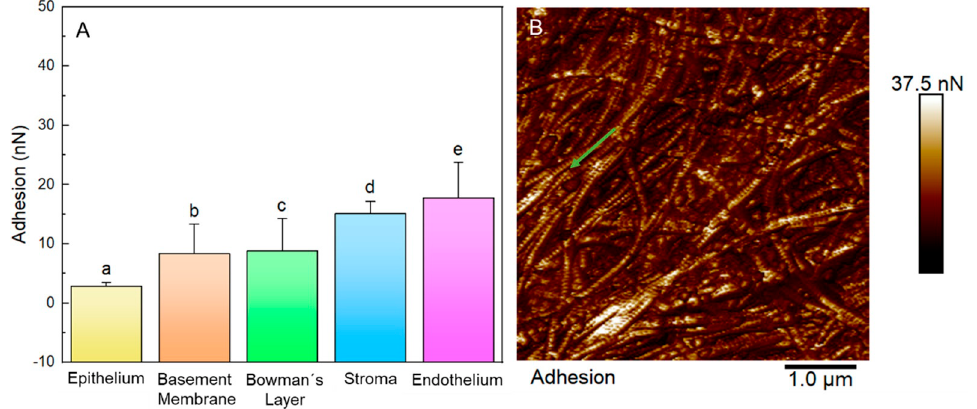
Figure 8. Adhesion data. ( A ) Adhesion force data for each layer. The letters on the graphs indicate the groups with significant differences in the ANOVA test with Tukey’s post hoc for p < 0.05. ( B ) A representative adhesion force map (5 × 5 µm) was created for the Bowman’s layer. The lighter areas of the map correspond to the highest values of adhesion forces. The green arrow shows the pattern of adhesion forces on collagen fibers.